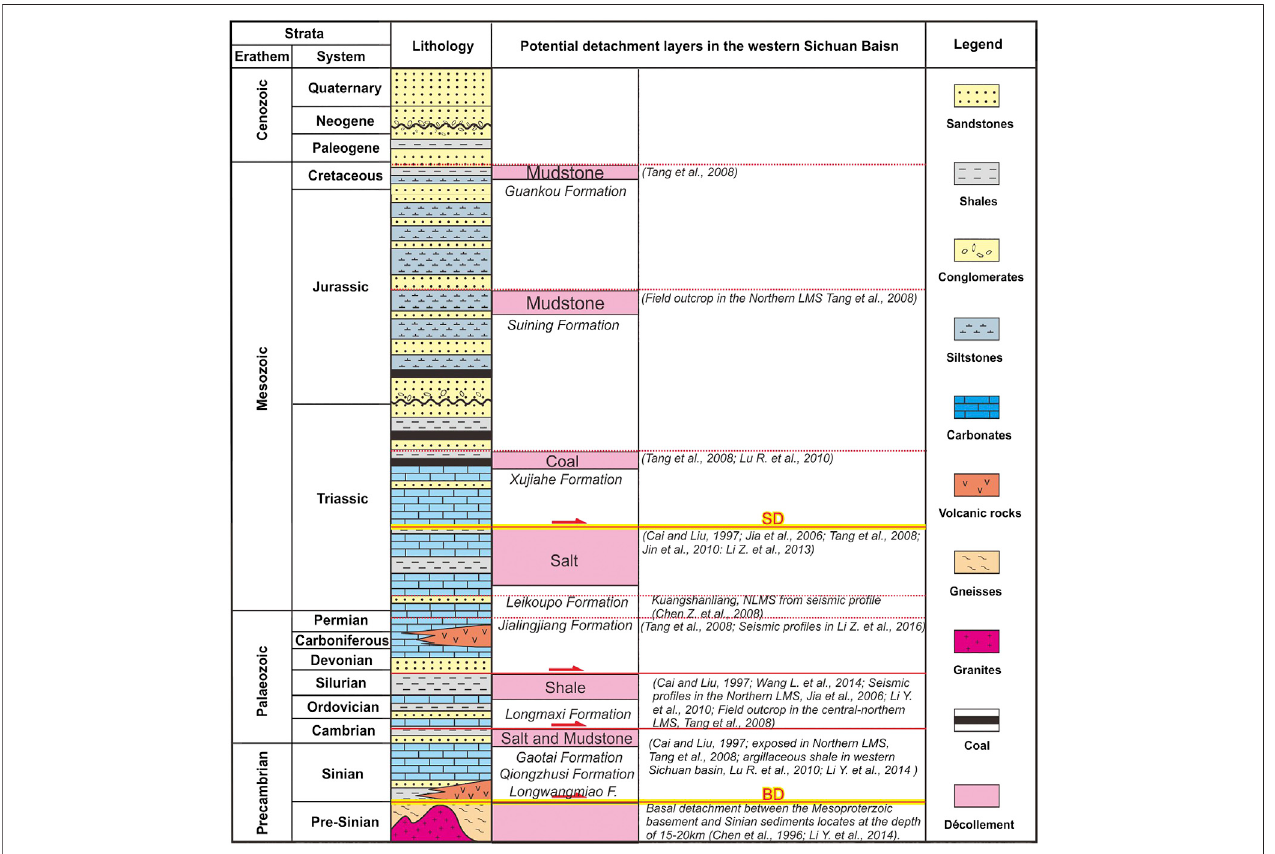
FIGURE3| Décollementlayersinthe WSFTB summarizedfromChenandWilson.(1996);CaiandLiu.(1997);Jiaetal.(2006);Chenetal.(2008);Tangetal.(2008); Jin et al. (2010); Li et al. (2013); Li et al. (2014); Li et al. (2016).